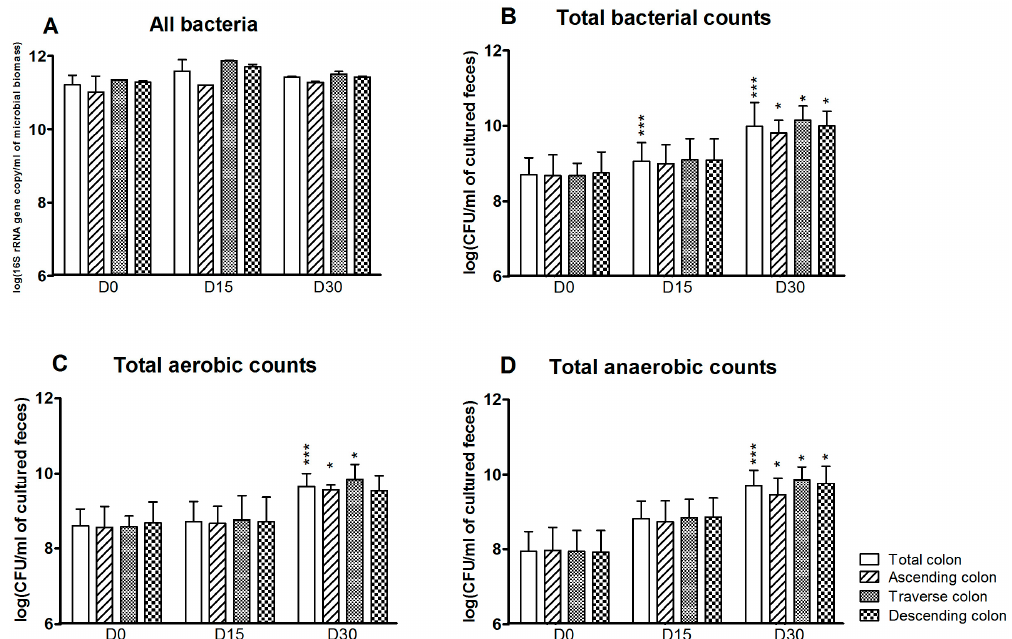
Figure 1. Total bacteria counts for the SHIME ® ’s colon as a whole and for each of the individual colon reactors at the end of the control period (D0) and after 15 and 30 days of exposure to pesticide chlorpyrifos (CPF) 1 mg/day in oil (D15 and D30). ( A ) Total bacterial counts determined by qPCR (Polymerase Chain Reaction) (log 16S rRNA gene copy/mL of microbioal biomass); ( B ) Total bacterial counts determined by plate culture (log CFU/mL of cultured feces); ( C ) Total cultured aerobe counts (log CFU/mL of cultured feces); ( D ) Total cultured anaerobe counts (log CFU/mL of cultured feces). Data are expressed as the mean ± Standard Deviation (SD) and were analyzed in a Kruskal Wallis test and then a Mann Whitney test. The level of statistical significance is indicated as follows: * p < 0.05; *** p < 0.001.